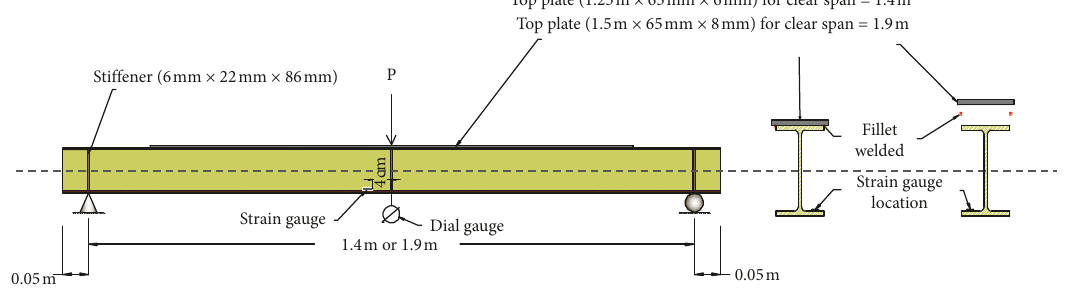
Figure 4: Details of tested steel beams and layout of dial and strain